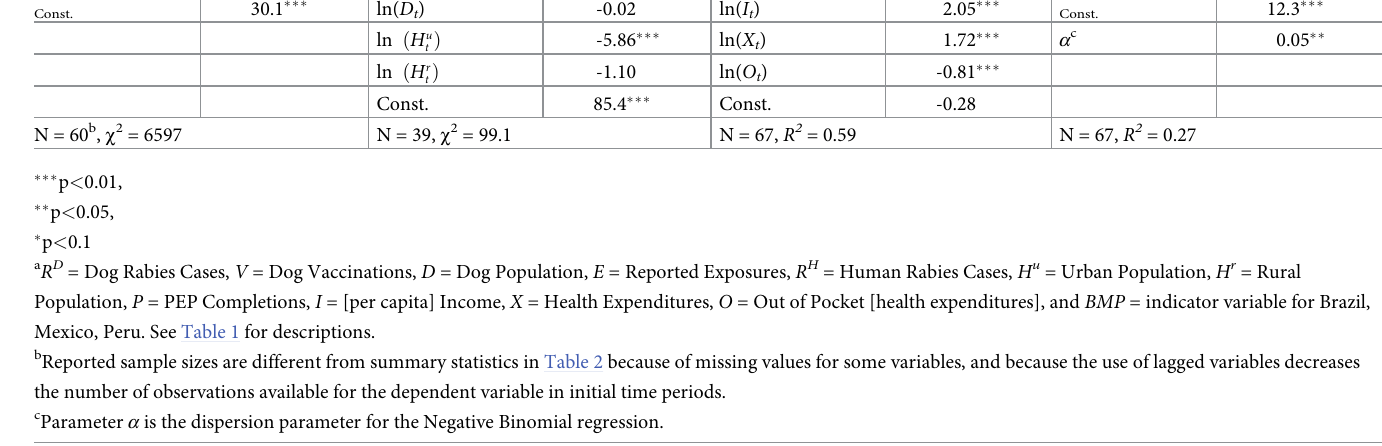
Table 3. Regression results for dog rabies cases, reported exposures, PEP completions, and human rabies cases, respectively. Regression